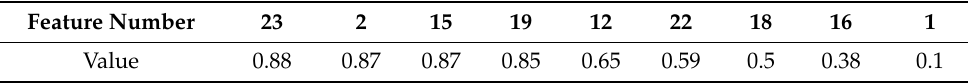
Figure 23. Correlation matrix of Bearing 1-1. Table 7. RMI of Bearing 1-1 optimal